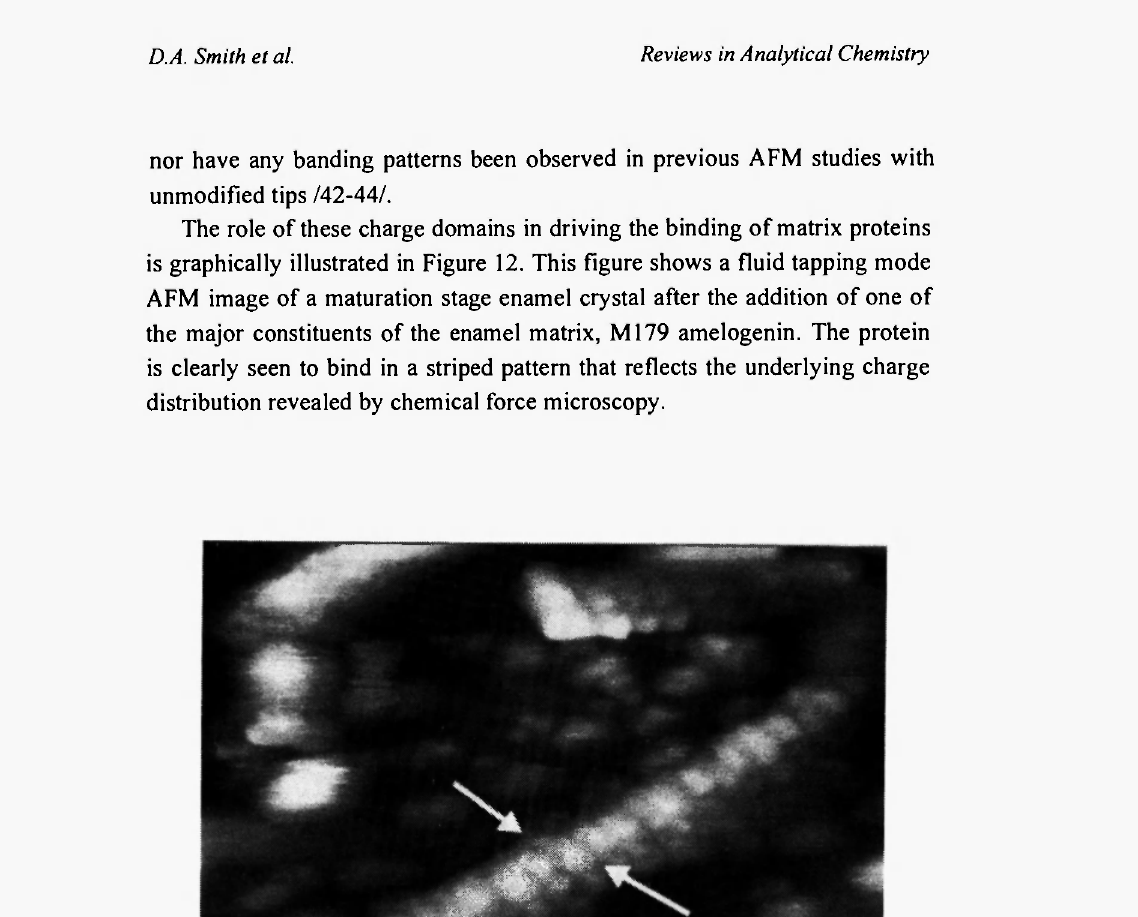
Fig. 12: Tapping mode AFM image in aqueous buffer of a maturation stage enamel crystal after the addition of Μ179, one of the principal constituents of the organic matrix. The protein can be clearly seen to bind in a banded patter highly reminiscent of the banded charge pattern that was revealed by